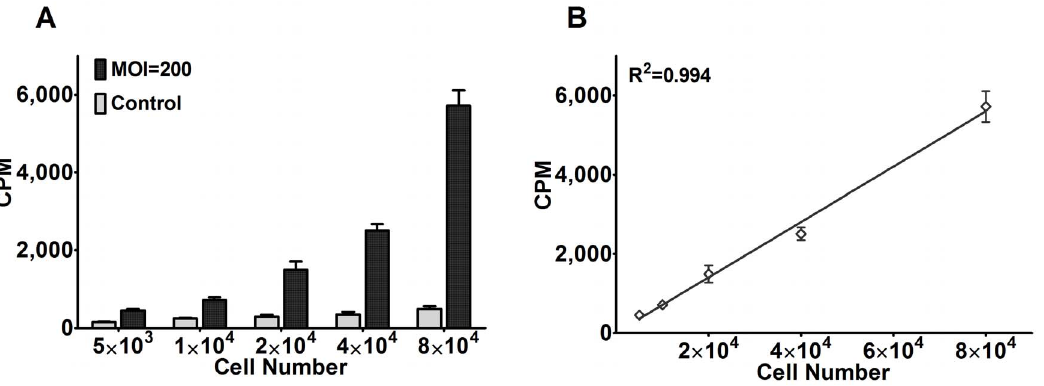
Figure 5. Correlation between 125 I uptake in Bac-NIS-infected hUCB-MSCs and cell number invitro . A : 125 I uptake (cpm) in Bac-NIS- infected and mock-infected hUCB-MSCs at MOI=200 in serially diluted cells (ranging from 5 6 10 3 to 8 6 10 4 per well). B : Correlation analysis between cpm and cell number of Bac-NIS-infected hUCB-MSCs. Results are means 6 SD (n=3).